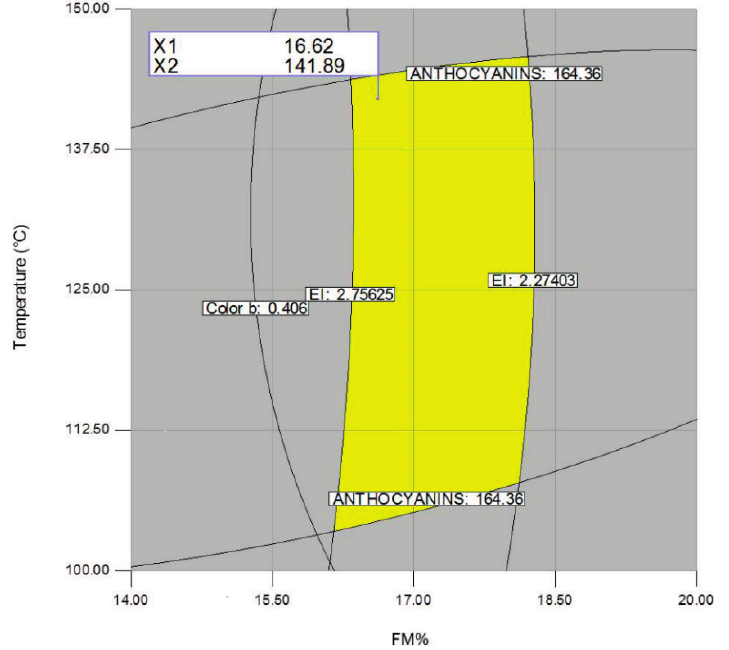
Figure 7. Overlay plot and optimized region (best combination) of the extrusion processing factors feed moisture (FM) and temperature (T), for producing expanded nixtamalized blue corn